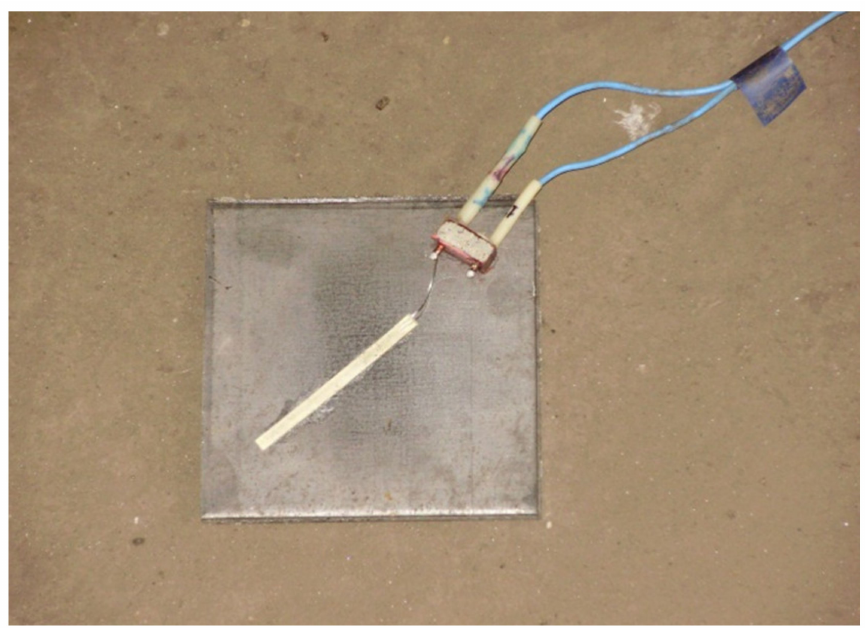
Figure 17. Compensating plate with a strain